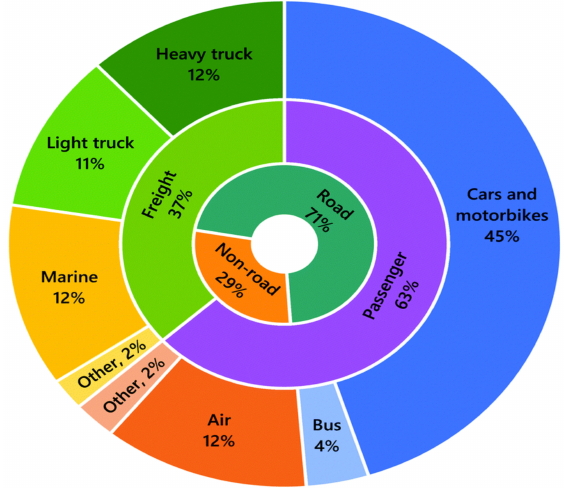
Figure 8. Summary of global energy utilization in the transport sector in 2015